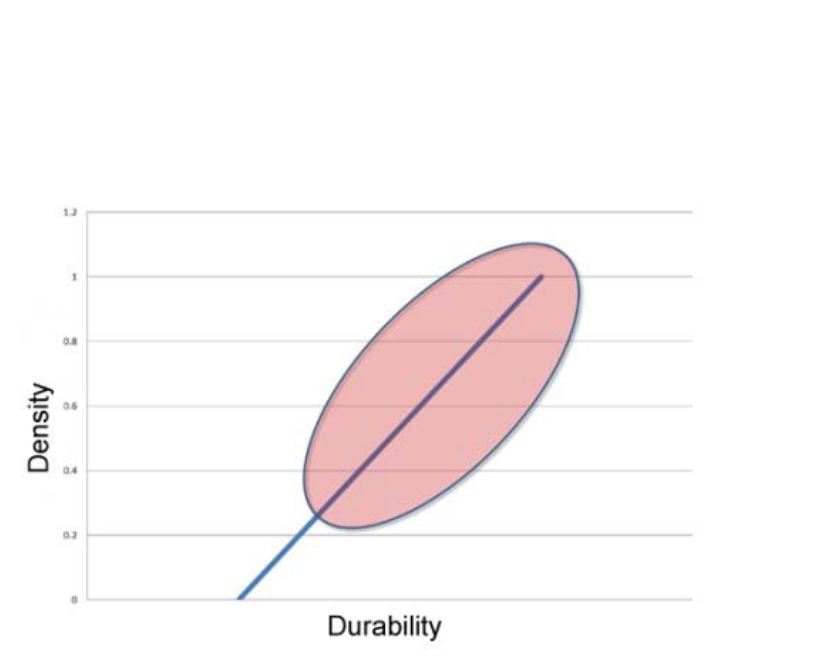
Figure 4 – The so-called cloud quality – density dependence Рис . 4 – « Облачная » взаимозависимость качество - плотность Слика 4 – Тзв . облак зависности квалитет –